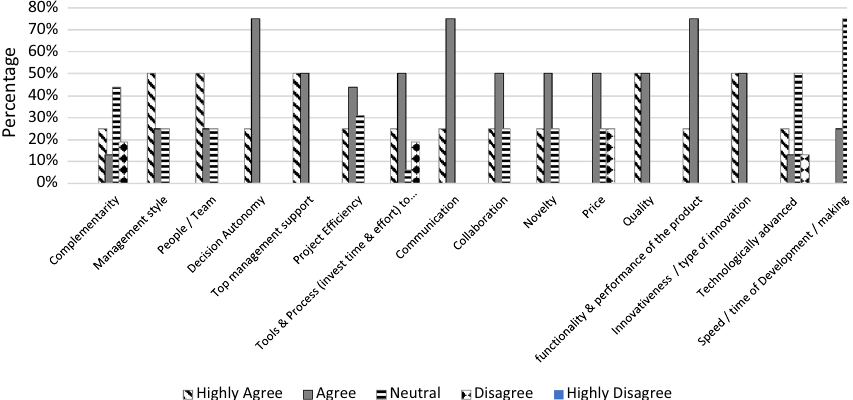
Fig. 6 Survey results related to product/project